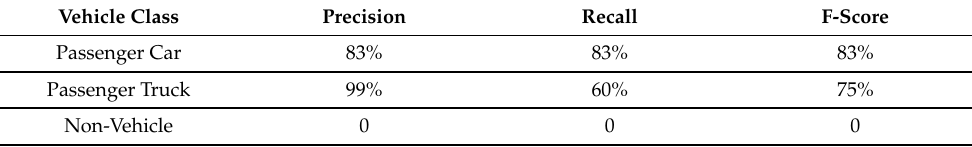
Table 9. Different evaluation metrics for detected vehicles in multiple vehicle clusters within Video